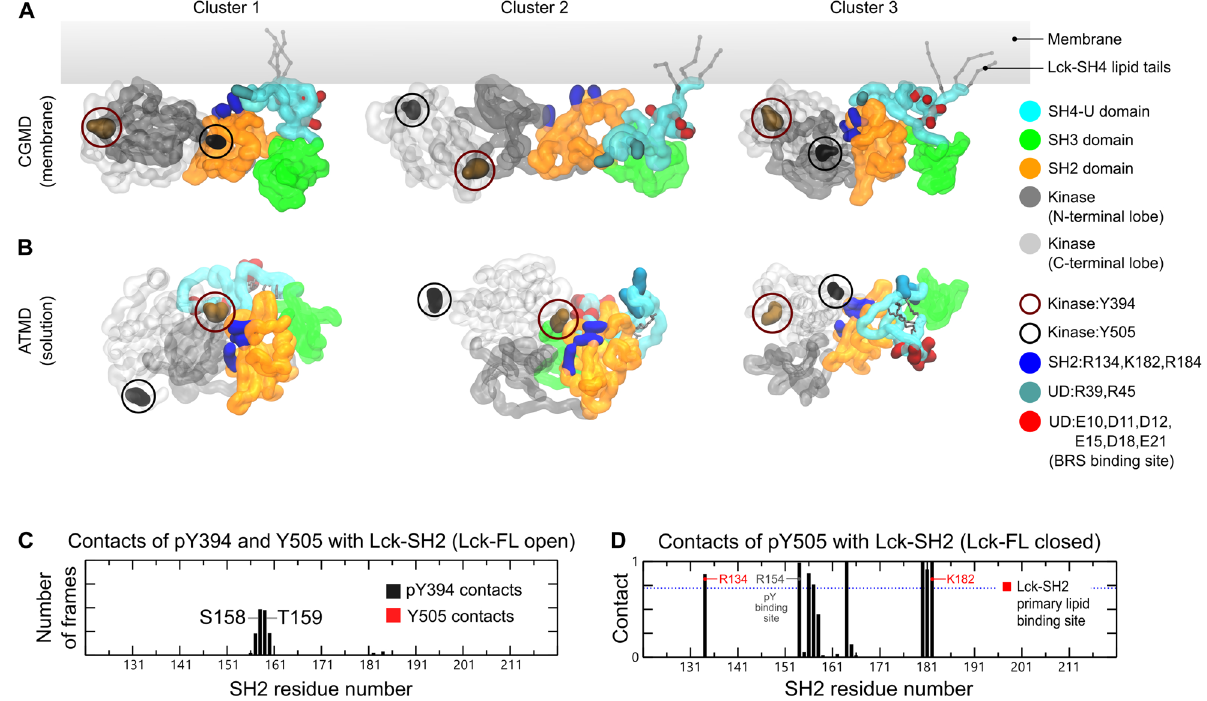
Figure 4. The flexibility of the kinase domain highlighted by the top three representative conformations of Lck-FL open ( A ) from CGMD (top) and ( B ) ATMD simulations (bottom) derived from clustering analyses (see main text for details). The kinase domain is made transparent to clarify the positions of Y394 and Y505. Y505 and Y394 which are shown in circles exchange positions relative to Lck-SH2, in both the membrane-associated form of Lck (CGMD) and in solution (ATMD) during our simulations. This indicates the rotation of the kinase domain relative to the SH2 domain that demonstrates the flexibility of the kinase domain. ( C ) Normalized average number of contacts of pY394 and Y505 with Lck-SH2 in the open Lck-FL state. ( D ) Normalized average number of contacts of pY505 with Lck-SH2 domain in the Lck-FL closed state in ATMD simulations. Normalization was done by dividing the number of contacts by the number of simulation frames thereby obtaining a scale of 0 to